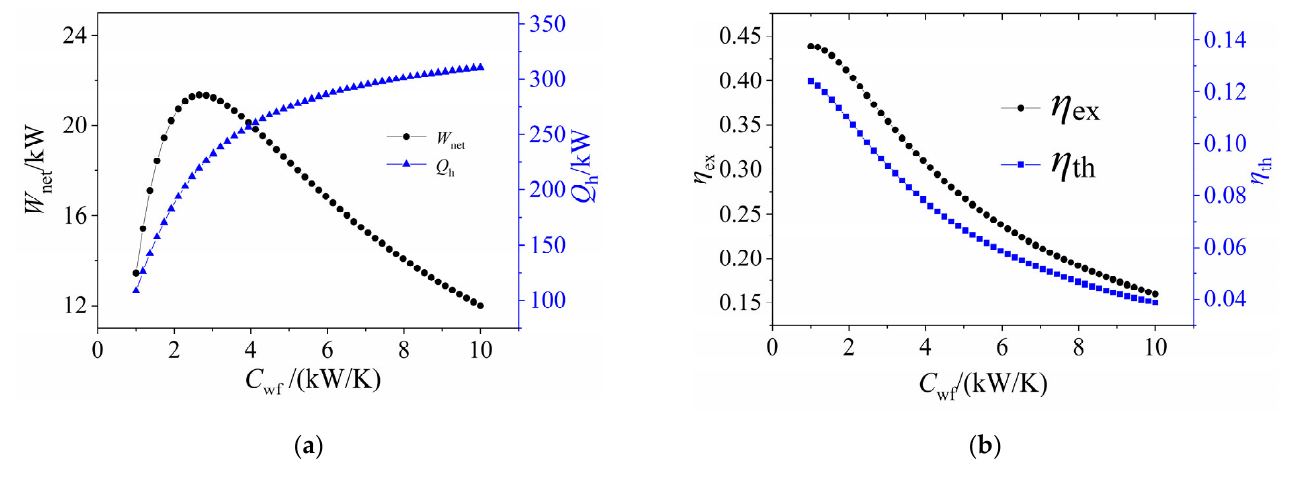
Figure 6. The impact of C wf on the thermal performance of the system for a constant ( kA ) h : ( a ) Q h and W net ; ( b ) η th and η ex .